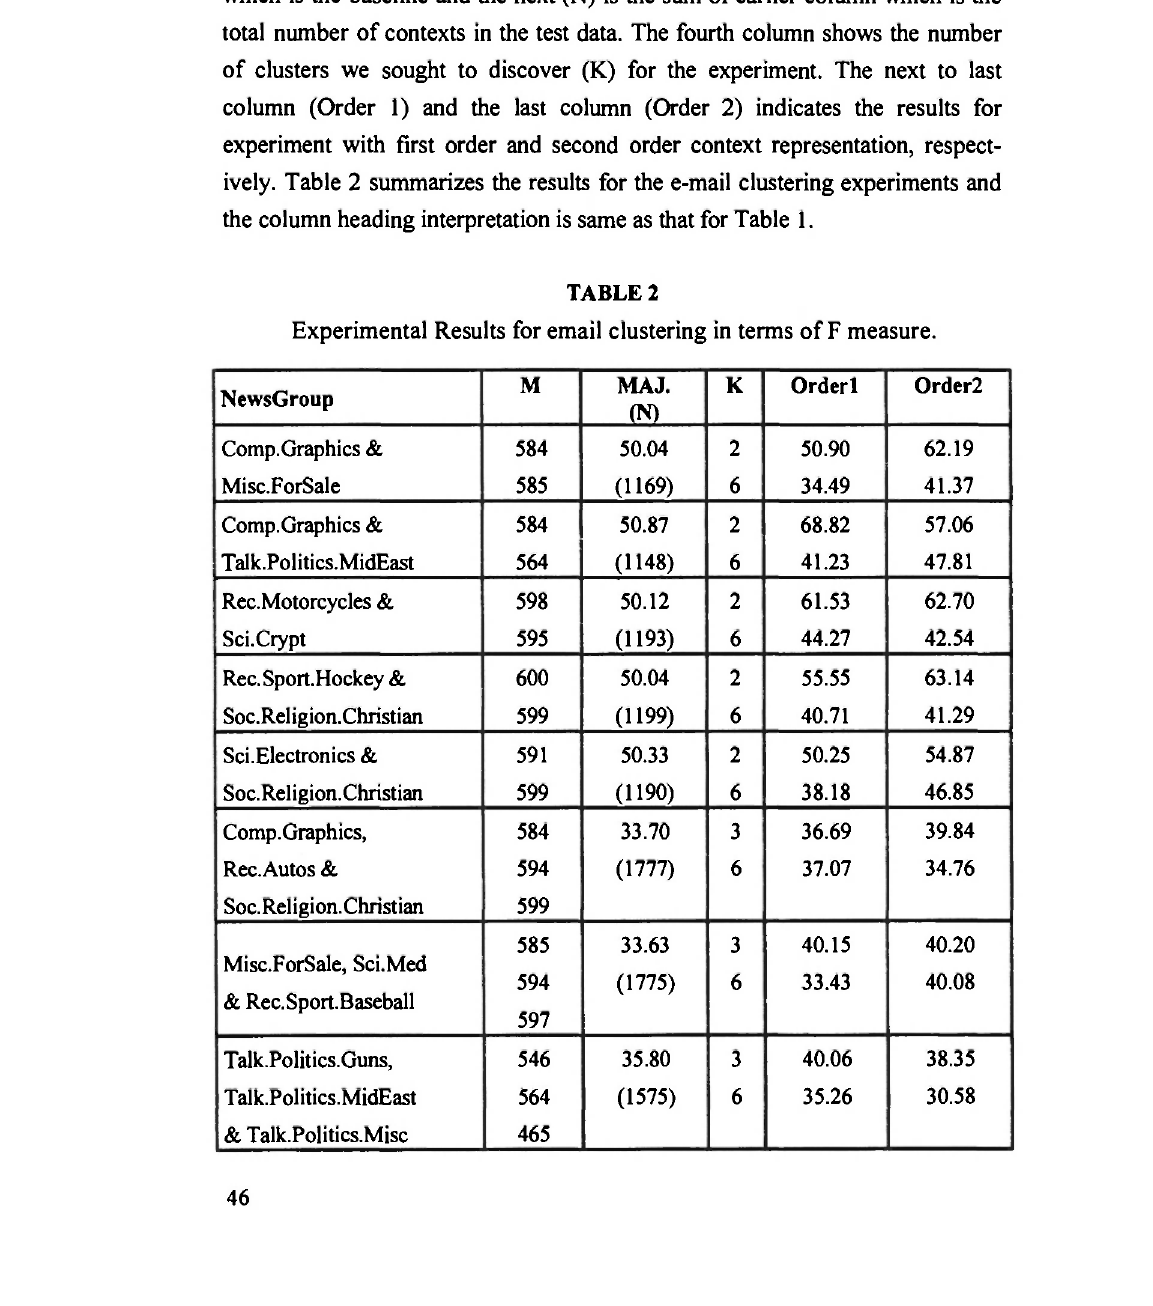
Experimental Results for email clustering in terms of F